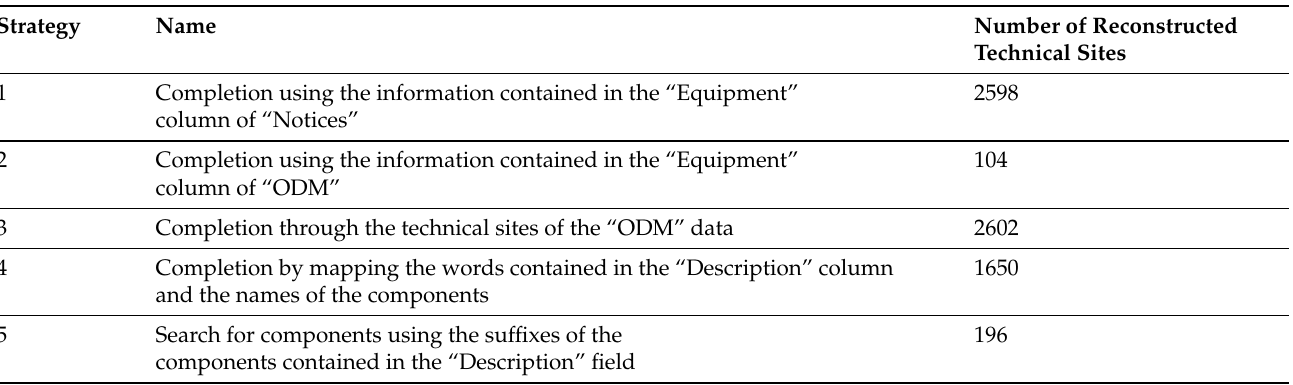
Table 11. Results of unstructured data reconstruction.